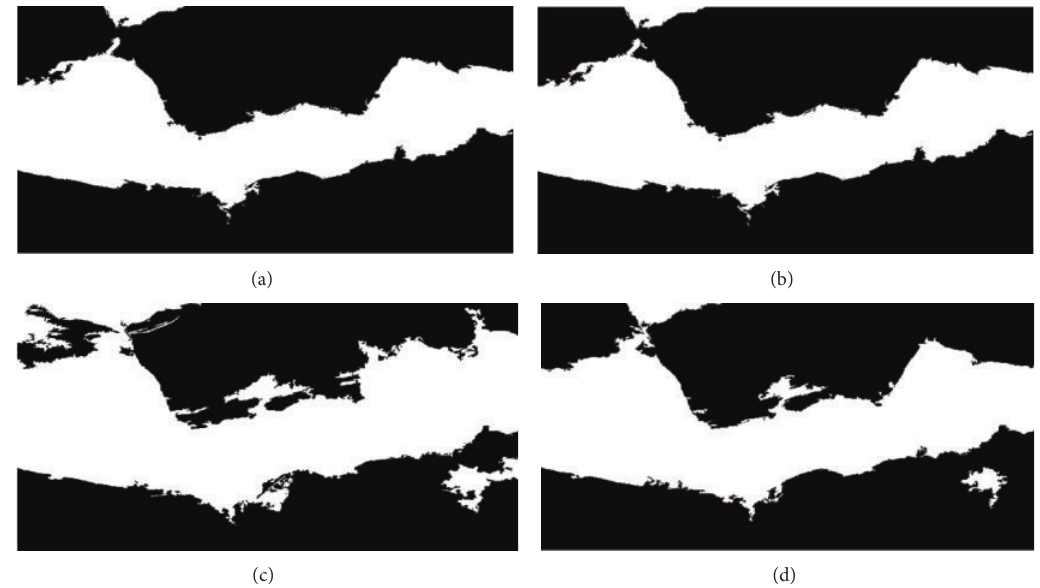
Figure 4: Binary images from saturation plane (HSV color system), obtained from the original image showed in Figure 1, applying different thresholding methods: (a) Otsu ( 𝑡 𝐴 = 57.57); (d) manual thresholding ( 𝑡 LE